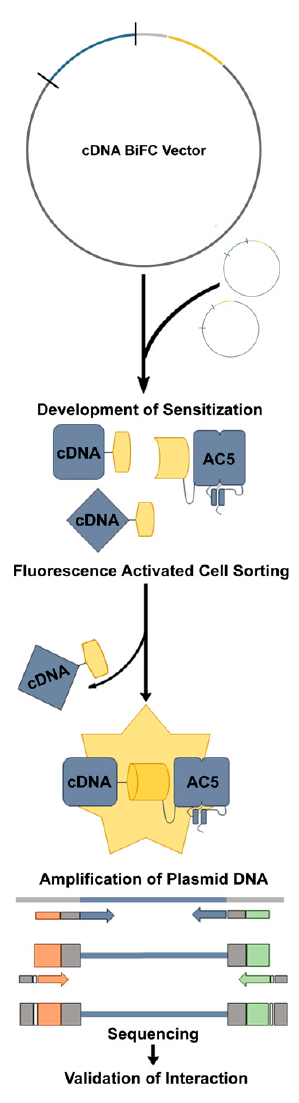
Figure 1. Screen workflow for the identification of adenylyl cyclase type 5 (AC5) interaction network partners using unique bimolecular fluorescence complementation (BiFC) tagged cDNA library. A unique human brain cDNA library was cloned into the BiFC plasmid, such that each cDNA would be expressed linked to the C-terminal fragment of Venus (i.e., cDNA-VC). The BiFC tagged cDNA library was transiently expressed into CAD VN-AC5 / D 2L , and the development of